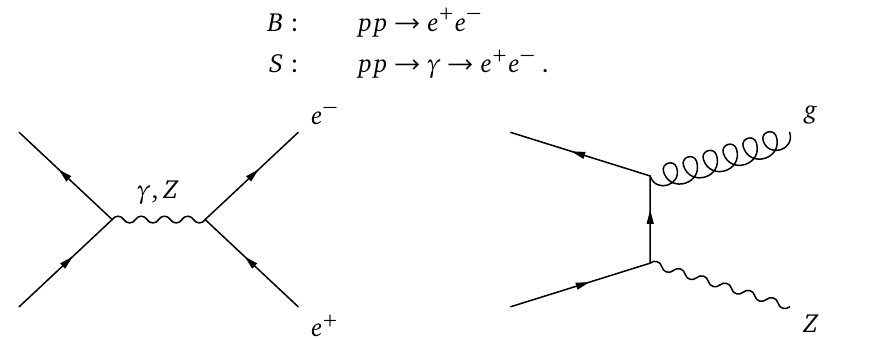
Figure 5: Sample Feynman diagrams for the background subtraction (left) and collinear subtraction (right)